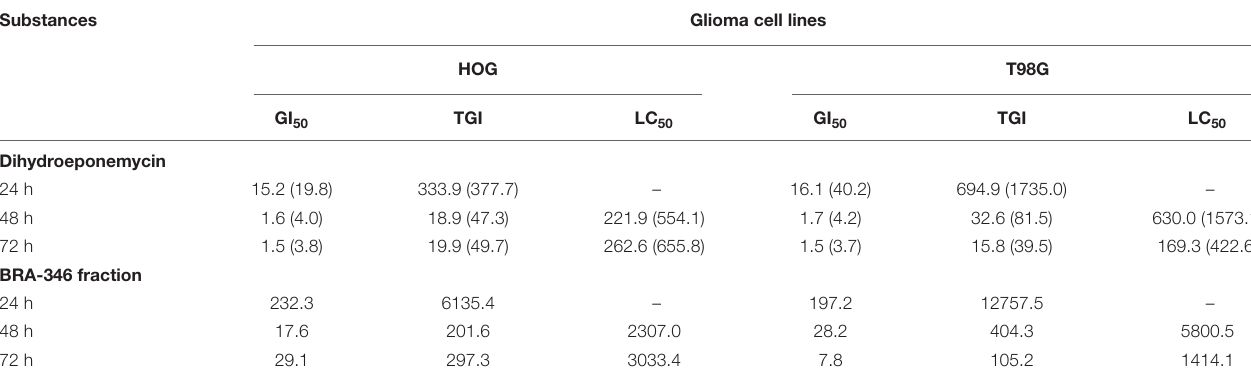
TABLE 1 | Evaluation of cell growth inhibition of HOG and T98G cell lines exposed to dihydroeponemycin (DHE) and BRA-346 epoxyketone-containing fraction through SRB assay after 24, 48, and 72 h